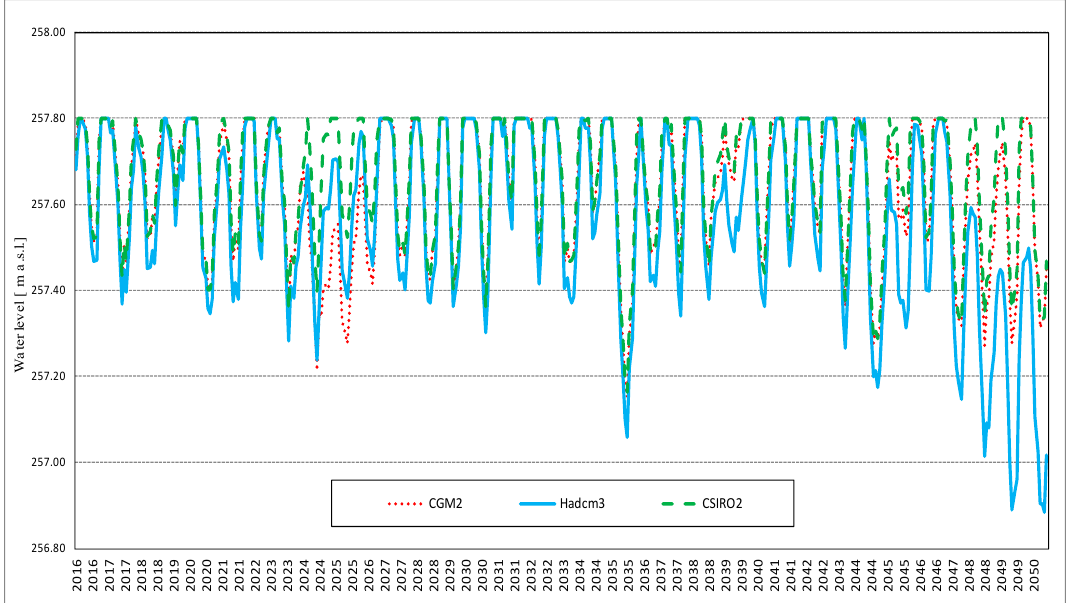
Figure 14. Predicted trends of Lake Trasimeno levels in the period 2016–2050, scenario A1F1.